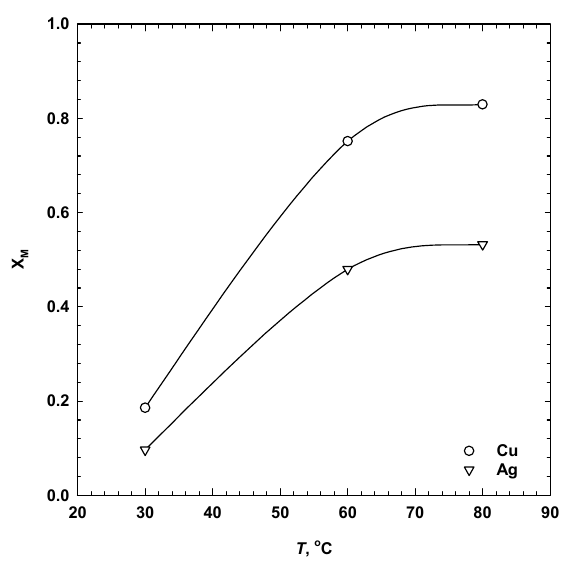
Figure 7. Influence of temperature on the ultimate dissolution of copper ( a ) and silver ( b ) after 24 h (1 M H 2 SO 4 , 1 M NaCl, 13.5 g/dm 3 MnO 2 , 30 g/dm 3 SMS, 300 rpm).